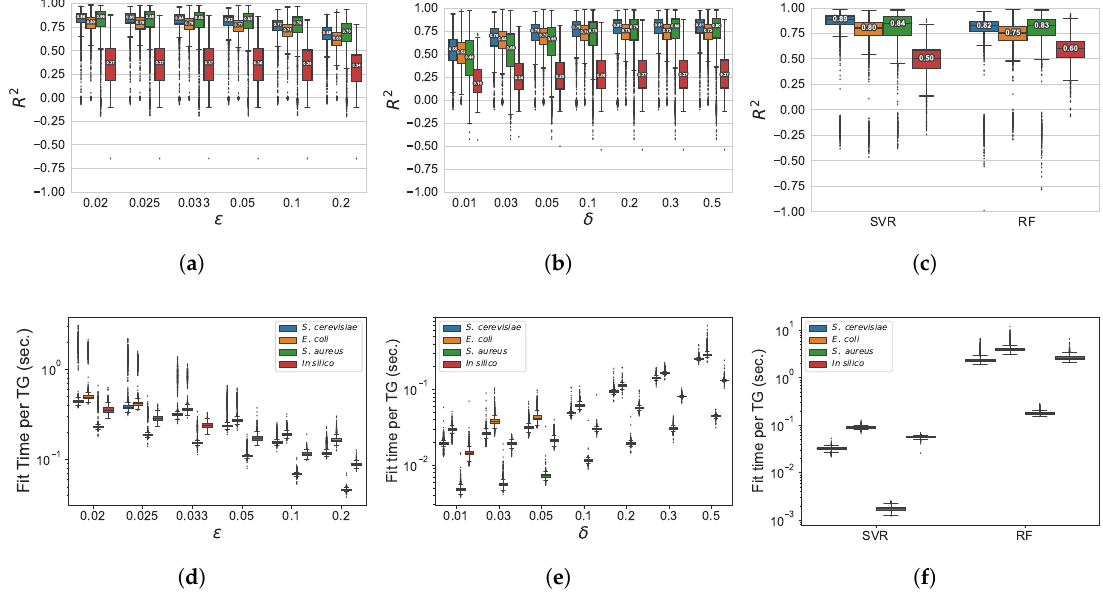
Figure 3. Average cross-validation R 2 scores for the GXN•EN ( a ), the GXN•OMP ( b ), as well as SVR and RF ( c ) state-of-the-art models. Average training run-times for the GXN•EN ( d ), the GXN•OMP ( e ), as well as SVR and RF ( f ) state-of-the-art methods. These results were obtained, on the